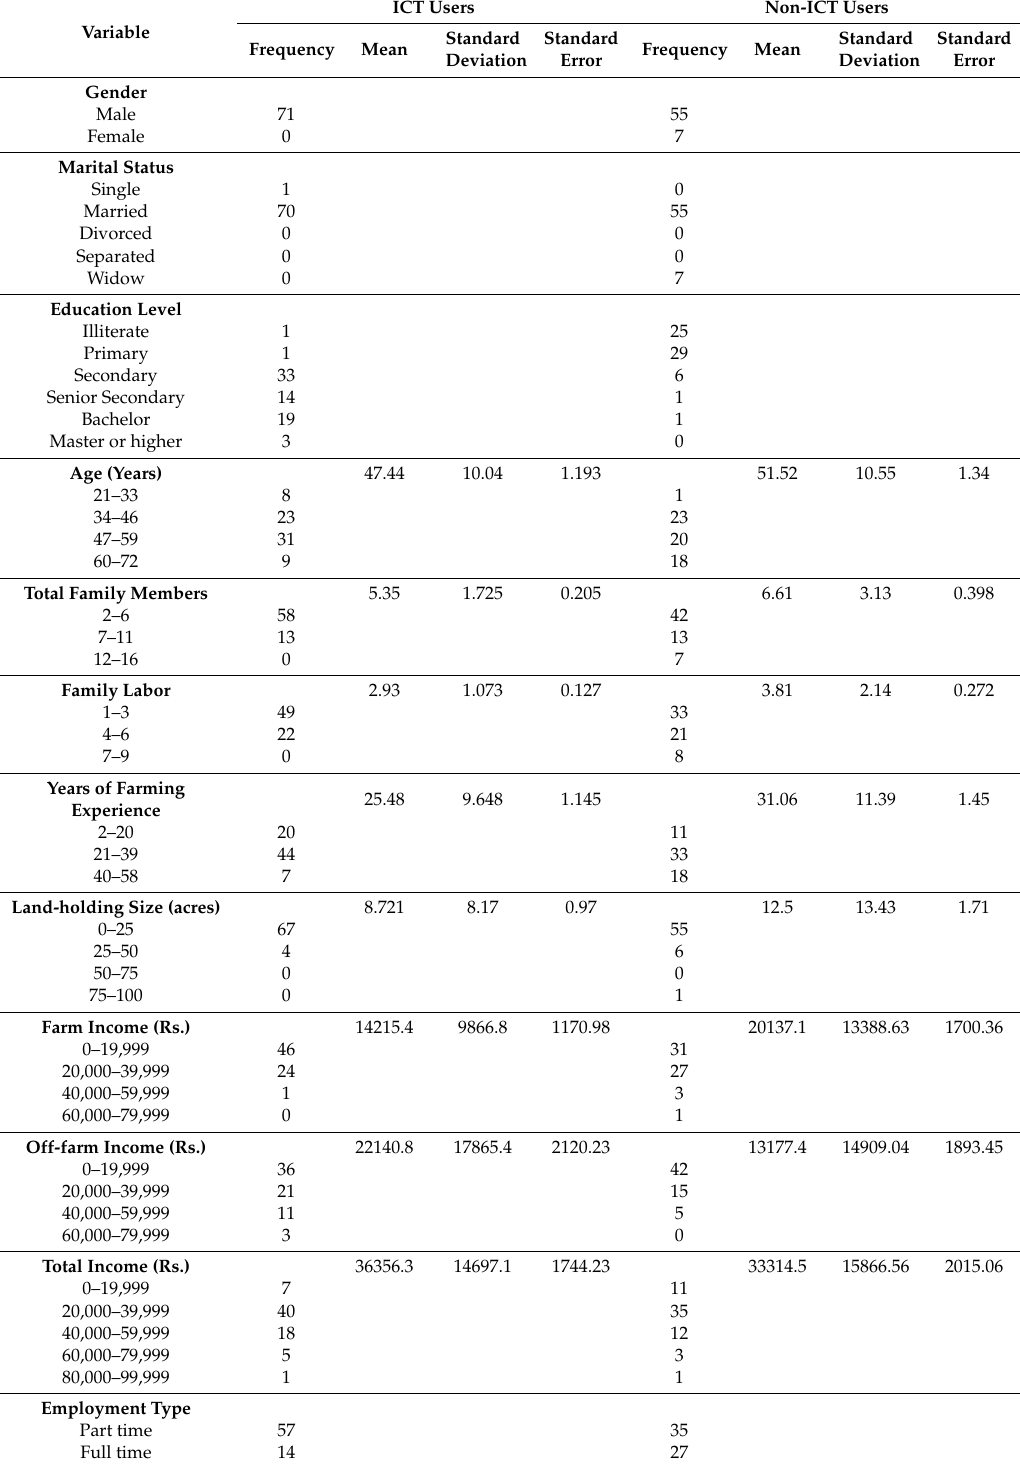
Table 2. Socio-economic characteristics of the